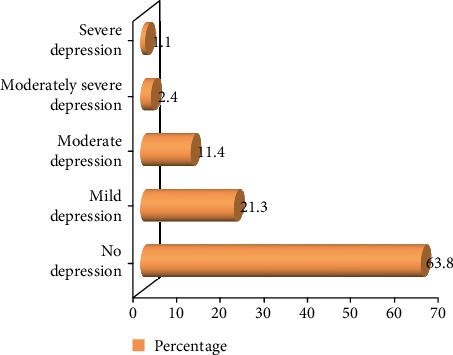
Characterization of depression severity among adolescents in governmental high schools at Aksum town, 2019 (n = 624).